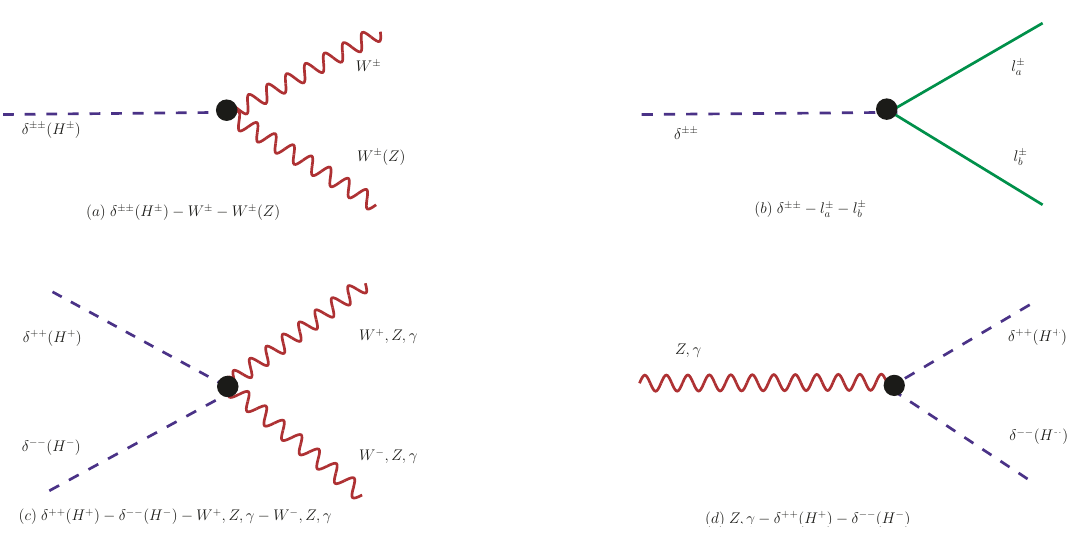
Figure 11. E(cid:11)ective interaction vertices between charged scalars and gauge bosons in MLRSM model. Decay of doubly charged scalar is driven by: (a) (cid:14) (cid:6)(cid:6) - W (cid:7) - W (cid:7) and (b) (cid:14) (cid:6)(cid:6) - l (cid:7) The vertex (c) (cid:14) ++ ( H + )- (cid:14) (cid:0)(cid:0) ( H (cid:0) )- W + - W (cid:0) is relevant for VBF process. The vertex (d) (cid:14) ++ ( H + )- (cid:14) (cid:0)(cid:0) ( H (cid:0) )- Z ( (cid:13) ) participates in the s -channel pair production of doubly (singly) charged scalar. The [ ] depicts the modi(cid:12)ed Feynman vertex (renormalizable + corrections due to dimension-6 (cid:15) operators).